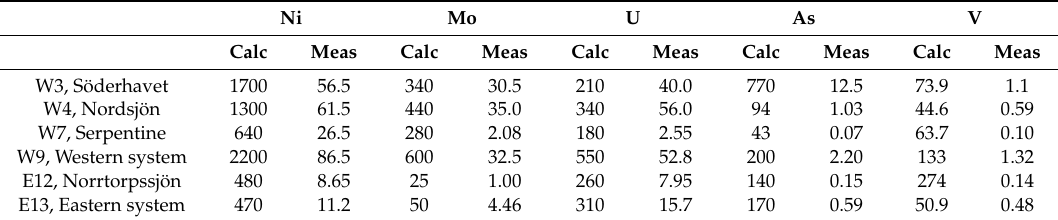
Table 10. Release of trace elements (kg) from the catchment area based on the mass fluxes in surface water sampling points and factors in Table 9 based on trace element / sulfate ratios. Average mass transport has been used for the calculations. Di ff erence between released amounts (calculated) and measured mass flux in the surface waters are assumed to be due to secondary immobilization (adsorption, precipitation,